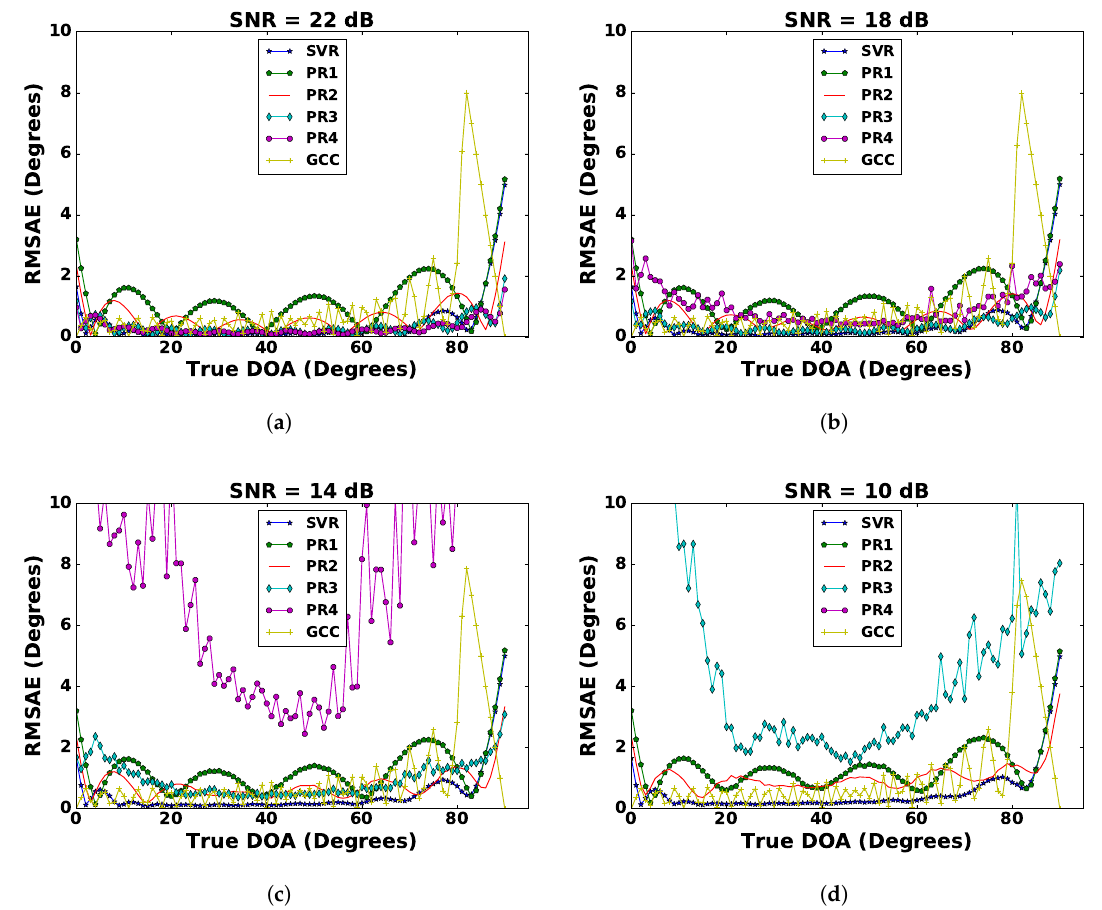
Figure 4. Comparison of different regression techniques (SVR, PR1, and PR2) and the GCC with curve fitting for ( a ) SNR = 22 dB, ( b ) SNR = 18 dB, ( c ) SNR = 14 dB, and ( d ) SNR = 10